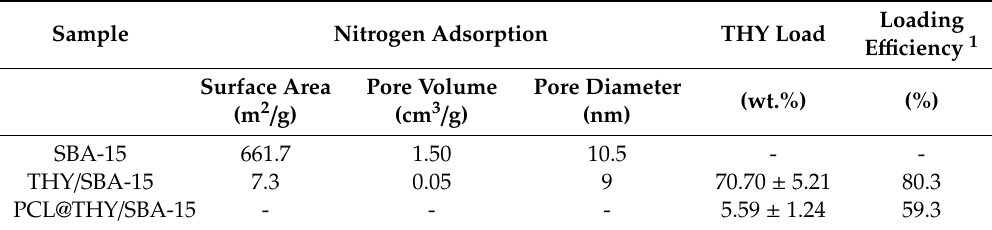
Table 1. SBA-15 nitrogen adsorption and THY loading